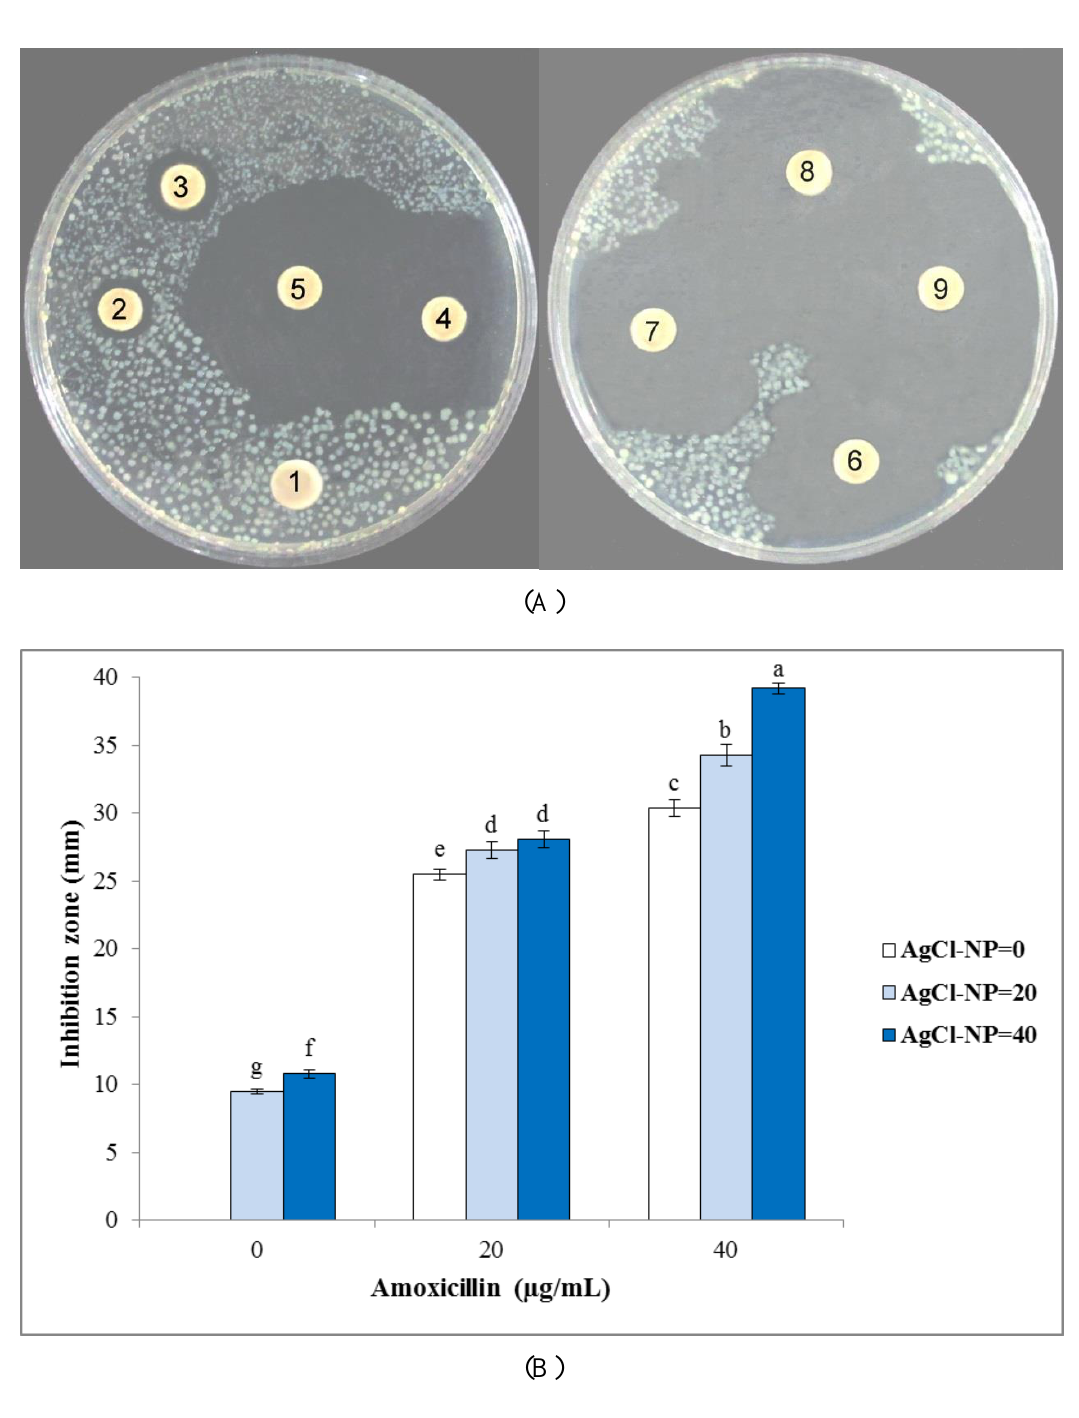
Figure 5. Antibacterial activities of biosynthesized AgCl-NPs against Staphylococcus aureus . ( A ) Disk diffusion assay. Different disc numbers showed various concentrations of AgCl-NPs and amoxicillin, as explained in the Material and Methods section (1: control, 2: 20 µg/mL of AgCl-NPs, 3: 40 µg/mL of AgCl-NPs, 4: 20 µg/mL of amoxicillin, 5: 20 µg/mL of AgCl-NPs + 20 µg/mL of amoxicillin, 6: 40 µg/mL of AgCl-NPs + 20 µg/mL of amoxicillin, 7: 40 µg/mL of amoxicillin, 8: 20 µg/mL of AgCl-NPs + 40 µg/mL of amoxicillin, 9: 40 µg/mL of AgCl-NPs + 40 µg/mL of amoxicillin). ( B ) Inhibition zone diameter. Different letters indicate significant differences ( P < 0.05) among various treatments.